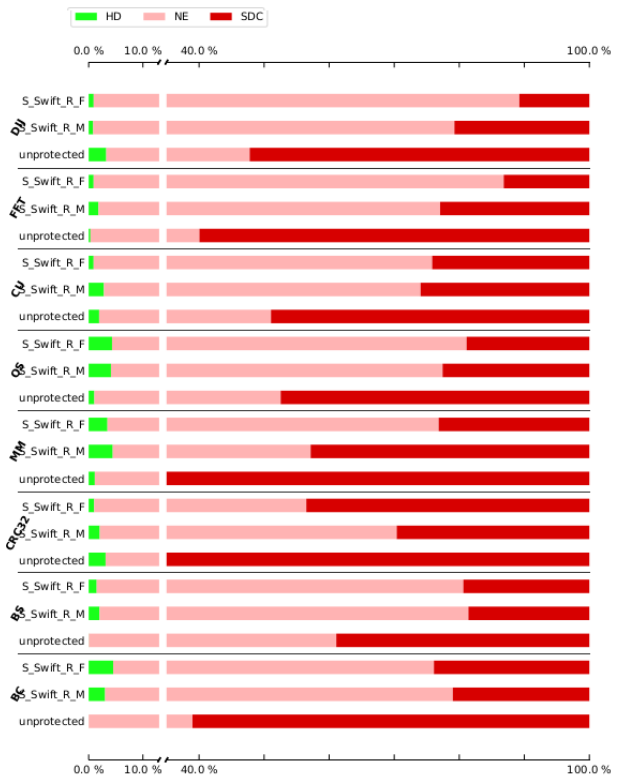
Figure A3. CFE fault injection results for 2